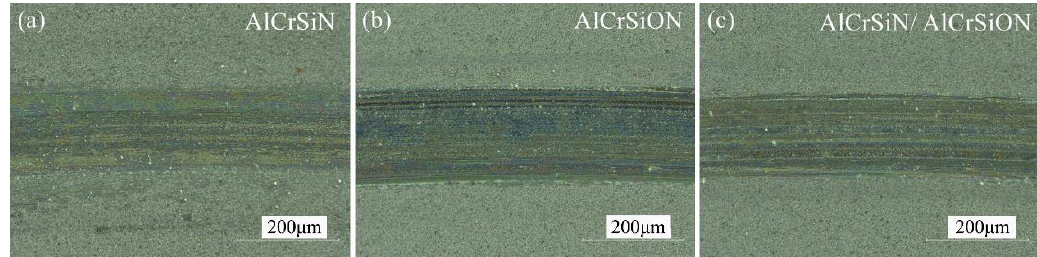
Figure 10. Morphologies of wear scar of the ( a ) AlCrSiN coating, ( b ) AlCrSiON coating, and ( c ) AlCrSiN/AlCrSiON duplex coating.